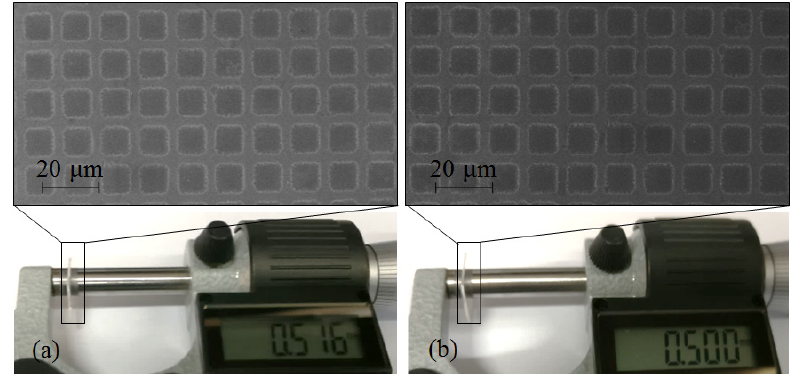
Figure 7. TEM etched structures by 6 μ m square array mould, ( a ) 25 min; ( b ) 8 h.